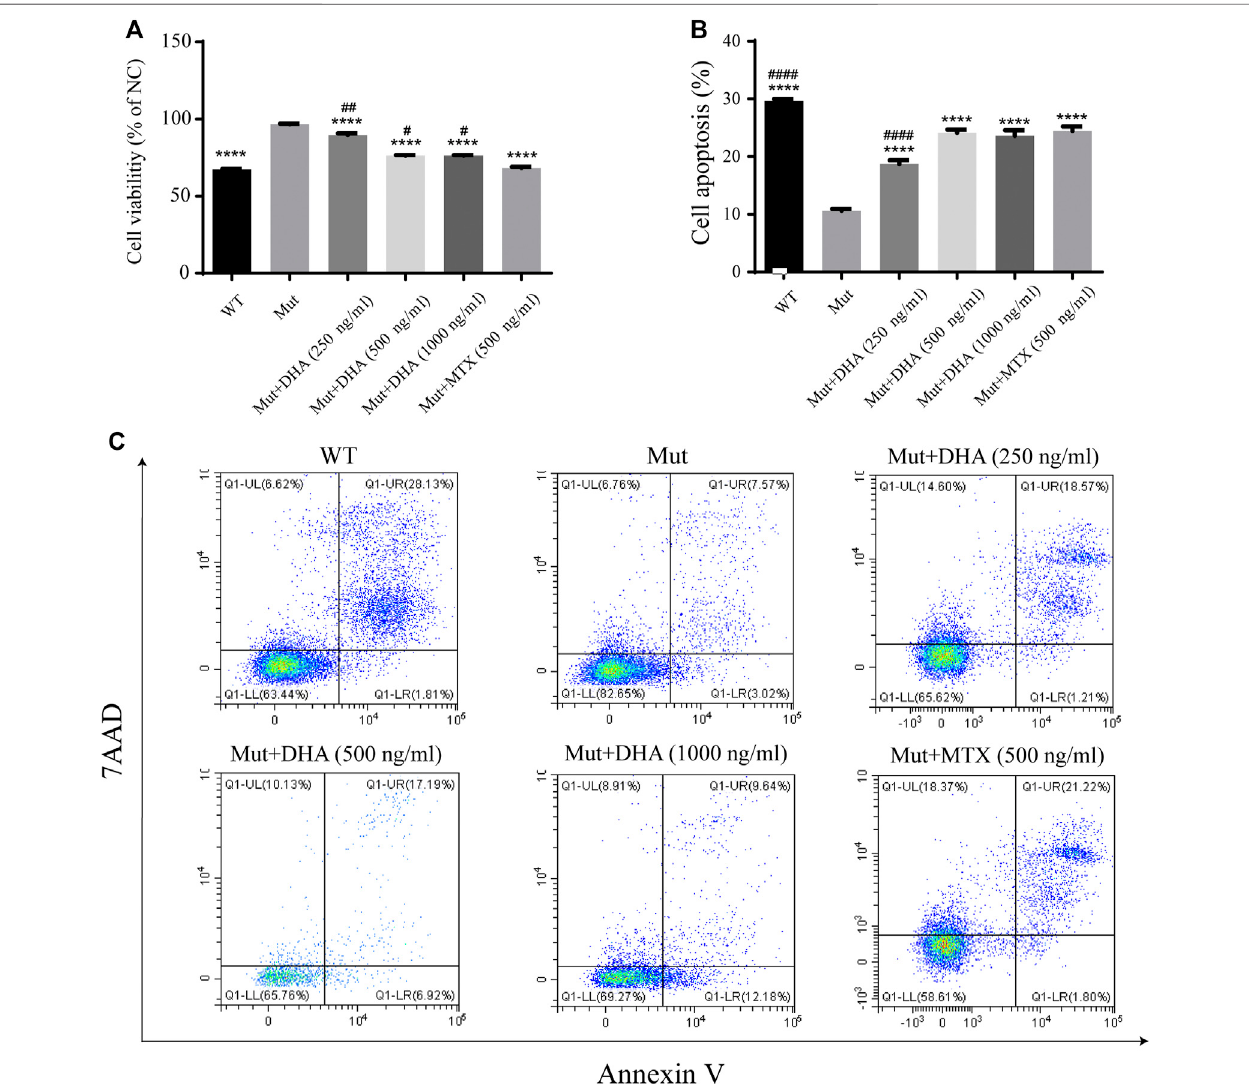
FIGURE 4 | DHA inhibited the proliferation and promoted the apoptosis of ST486 cells. (A) The proliferation rate was determined by CCK-8 method. (B,C) Using Annexin V apoptosis detection kit, the apoptosis rate was detected according to the manufacturer ’ s instructions. The levels of Annexin V and 7AAD were detected by FACSCalibur fl ow cytometry. The experiments were repeated three times and analyzed using one-way ANOVA. **** p < 0.0001 vs. the Mut group. # p < 0.05, ## p < 0.01 and #### p < 0.0001 vs. the MTX group.